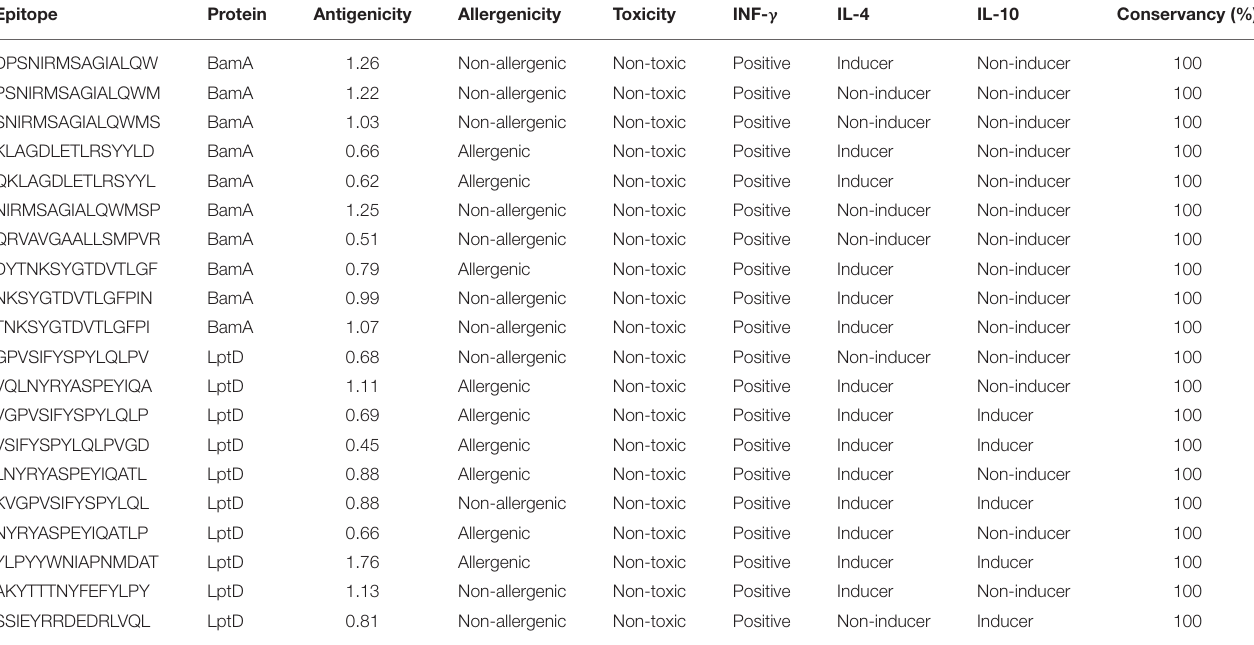
TABLE 2 | Top-ranked T-cell epitopes (MHC-II peptides) of BamA and LptD proteins.